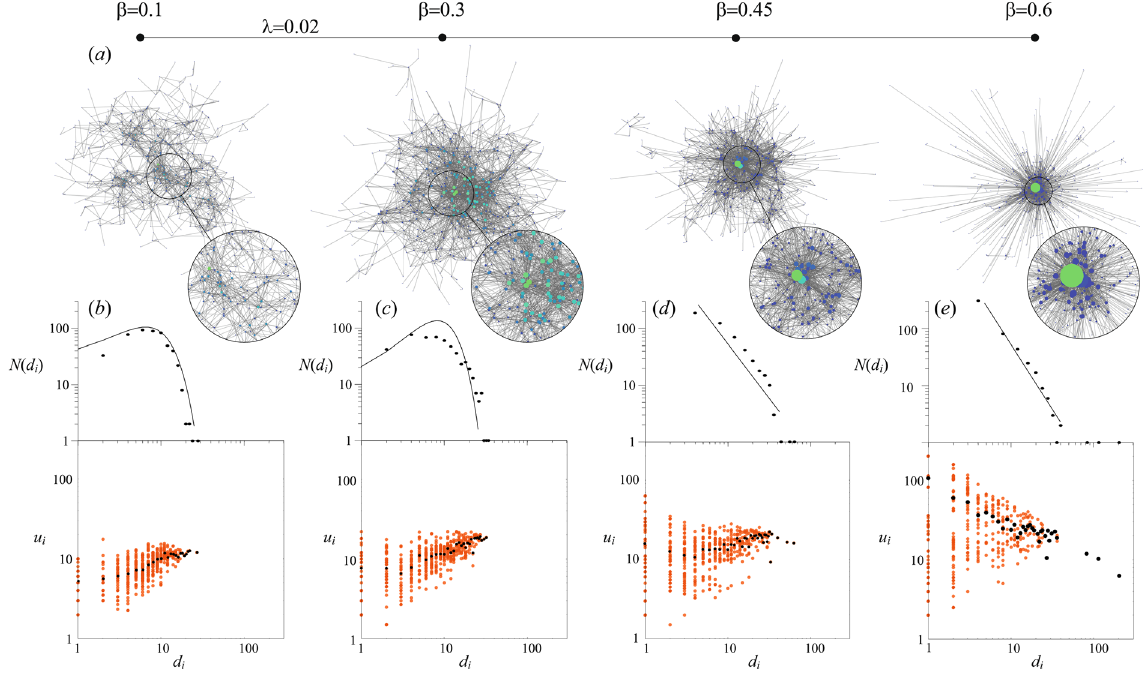
Figure 4. The topologies of the generated network when increasing the degree factor β in region III. ( a ) Spatial visualizations of the obtained network structures. The size and color of a node is proportional to its degree. The insets zoom on specific graph areas. N = 500. ( b – e ) Degree distributions ( N ( d i ), upper plots) and correlation between d i and u i (lower plots) at different β values: ( b ) β = 0.1, ( c ) β = 0.3, ( d ) β = 0.45, ( e ) β = 0.6. The black dots on the correlation plots mark the average values of u i for each d i value. The solid lines in the degree distributions are marking the fit with specific distribution functions: ( b , c ) Poisson distribution, with